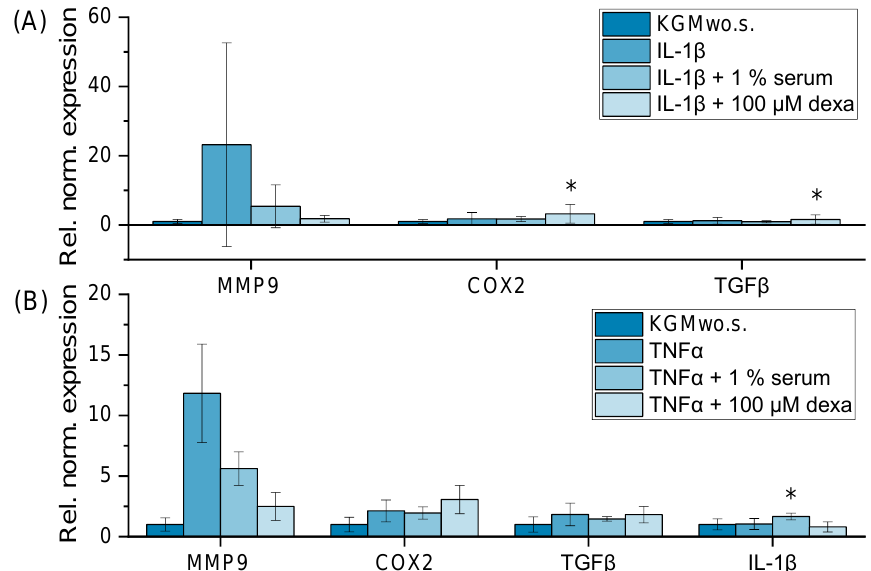
Figure 5. Relative normalized gene expression of MMP9, COX2, TGF β and IL-1 β in HCE-T cells; 24 h of cultivation with IL-1 β ( A ) or TNF α ( B ) (10 ng/mL) in KGMwo.s. medium; 3–6 wells per sample were analyzed (n well = 3–6); 2–3 technical replicates were conducted per well (n technical replicate = 2–3); mean ± SD, one-way ANOVA with * p ≤ 0.05.